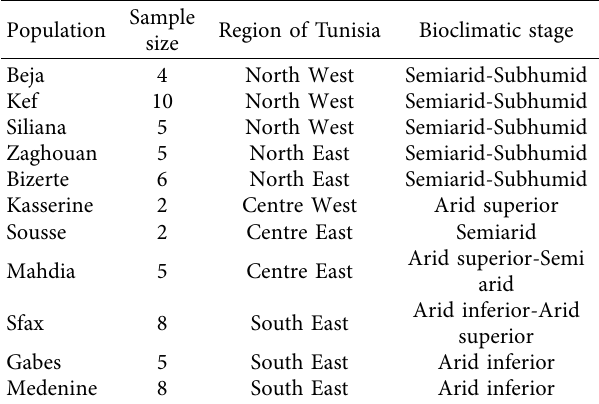
Table 1: Characteristics of the studied populations of Tunisian barley